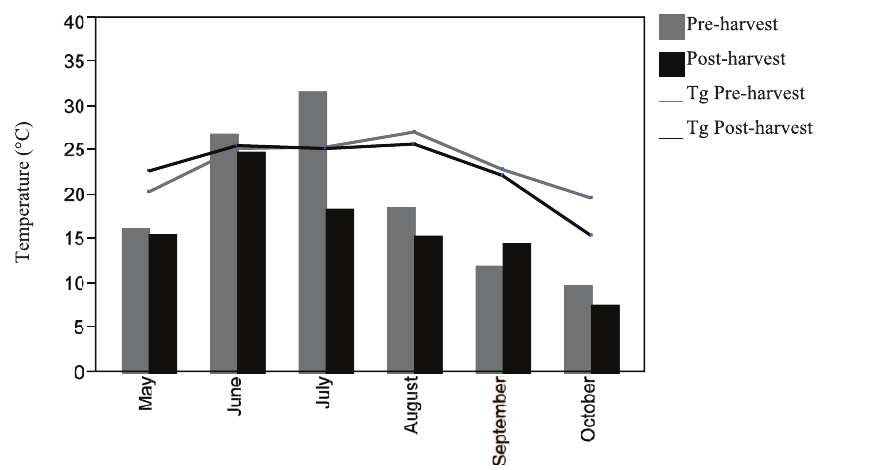
Figure 3. Pre vs. Post Movements. Average steplength (m/day) moved by eastern box turtles each month for both harvest periods (pre-harvest [2007–08] and post-harvest [2009–10]; bars). The average ground temperatures (Tg; u C) recorded at turtle location each harvest period are also plotted (lines).